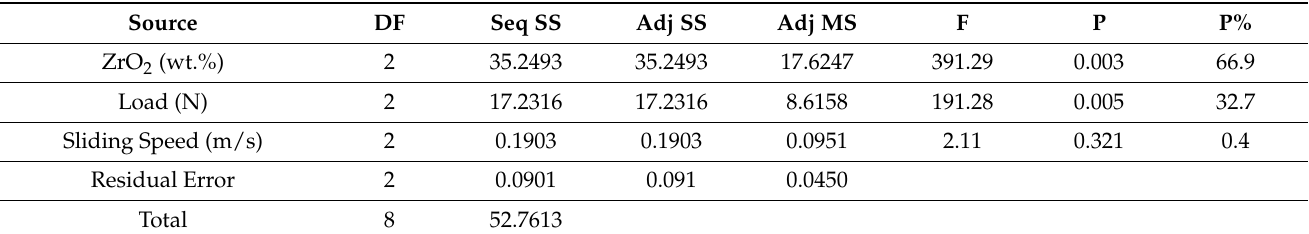
Table 9. Analysis of variance for S / N